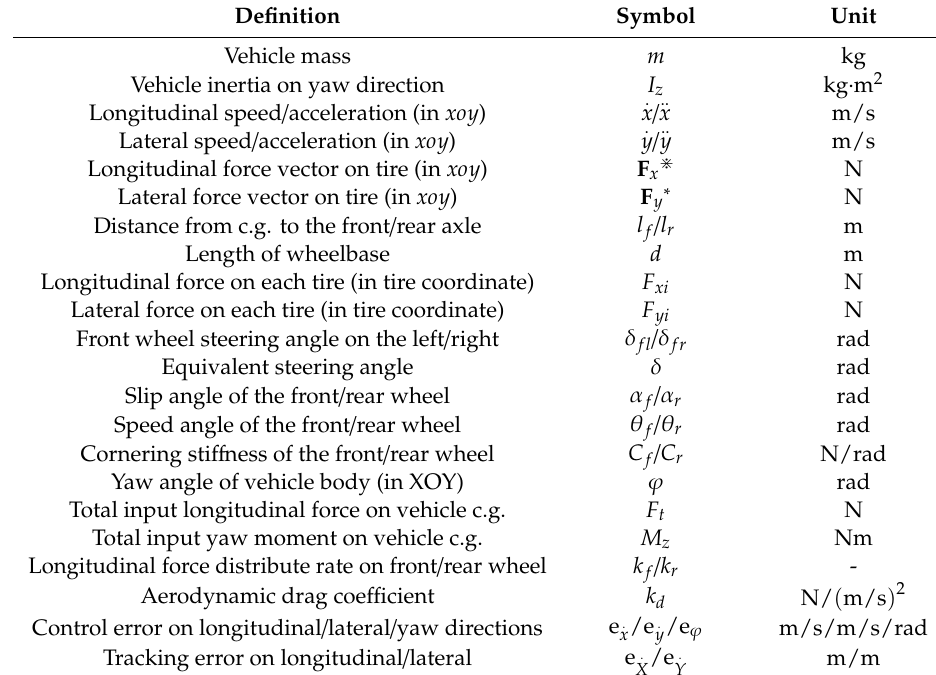
Table A1. Symbols and definitions of the dynamics model cited.